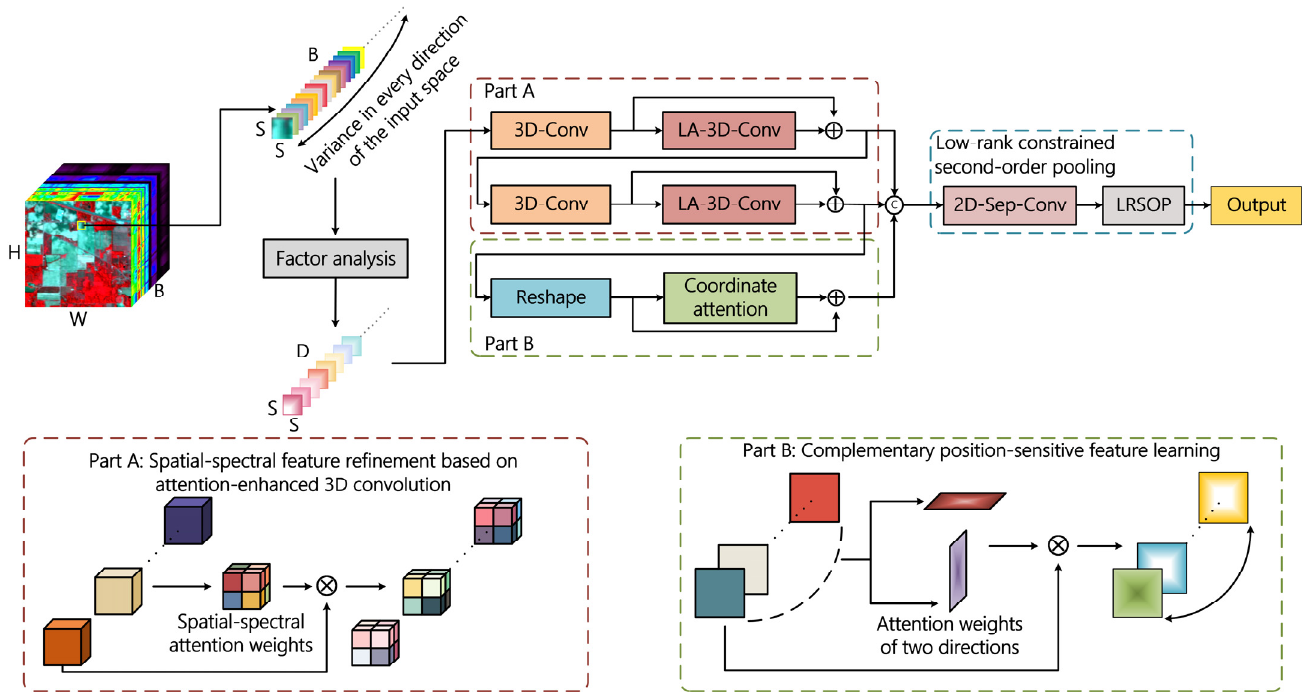
Figure 1. Hyperspectral classification diagram based on LAMFN.